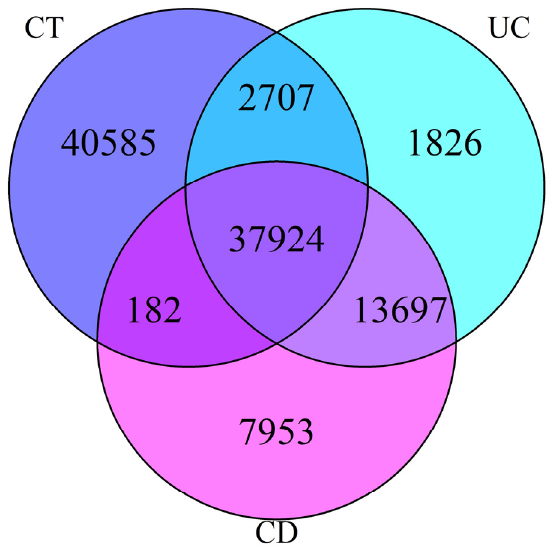
Figure 3. Distribution of S100B potentially interacting proteins in the three samples category.